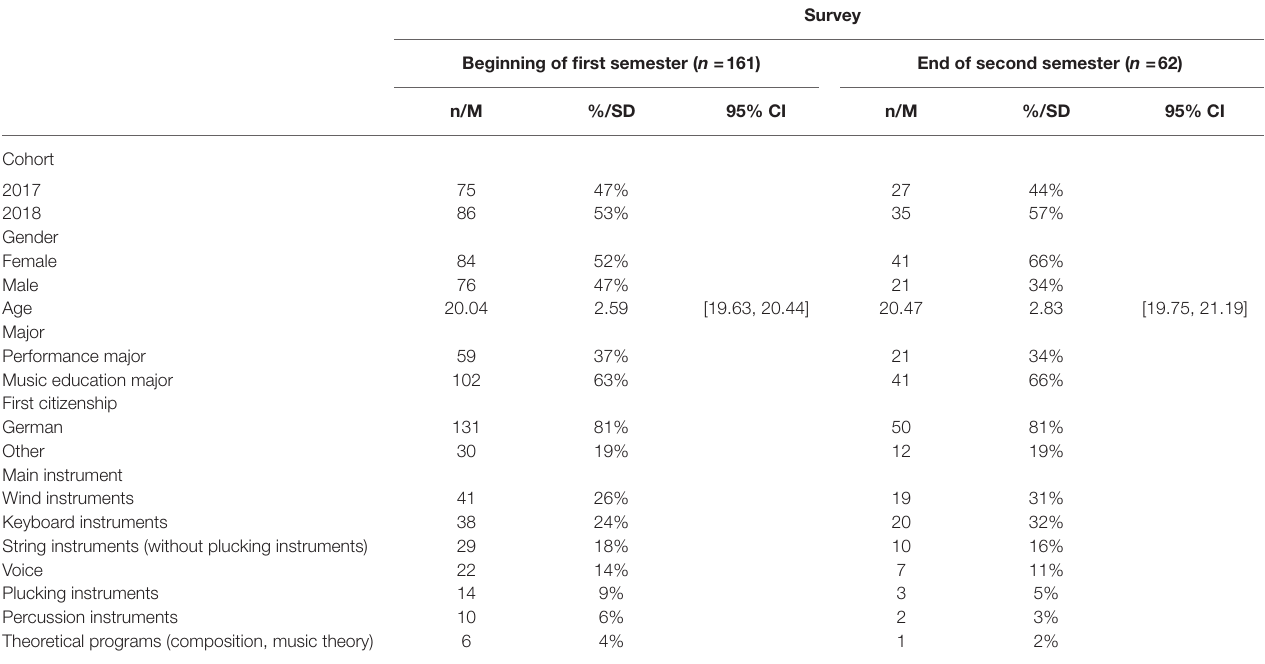
TABLE 2 | Comparison of the sample characteristics of the subsample of respondents from the cohorts of 2017 and